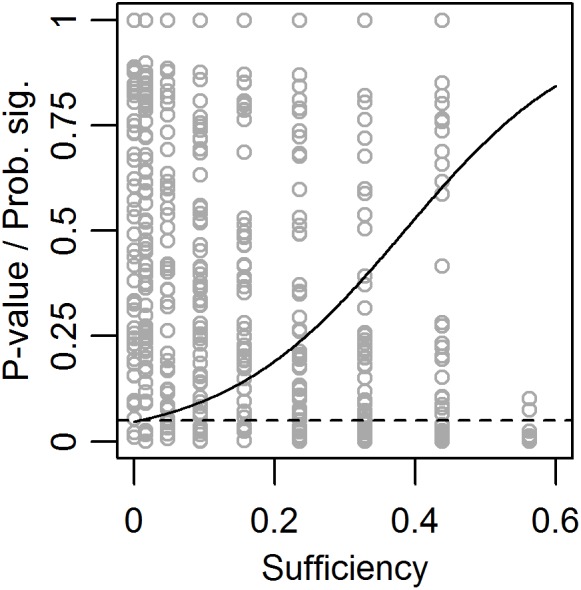
Observed p-values (dots) and predicted probability for a significant (p < 0.05) necessity effect (solid line) as functions of true population sufficiency effect when the true population necessity effect = 0. The dashed line shows the limit for p < 0.05.